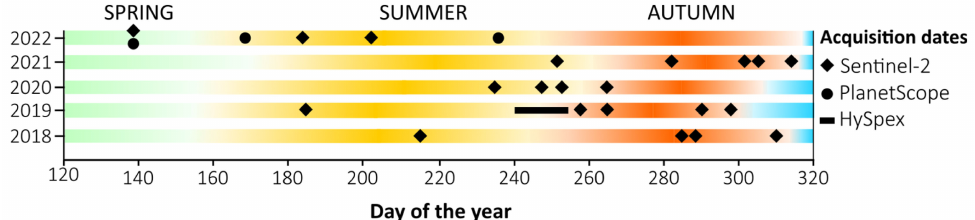
Figure 3. Sentinel-2 cloudless acquisition dates for years 2018–2022, depending on vegetation season; the start and end dates of vegetation were differentiated in the analyzed years. Source: Calculated based on ERA5 climate reanalysis data [34]. In the case of the HySpex image, due to a frequent cloud cover, the size of the area, significant elevation differences (this required flightlines at different altitudes to acquire comparable pixel sizes for the whole area), the area of the park was acquired in different